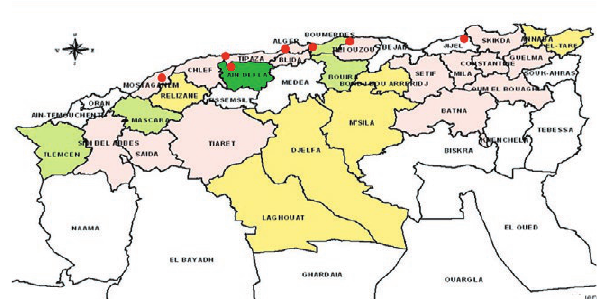
Figure 2. Surveyed and sampled Brassica- growing areas (red cir- cles) in Algeria (from